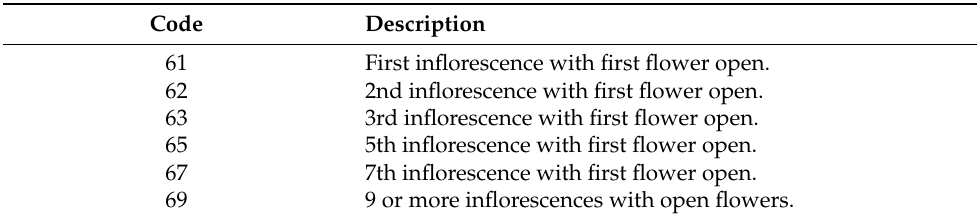
Table 5. Description of the principal stage 6 (flowering) of slender nightshade, based on the BBCH scale.